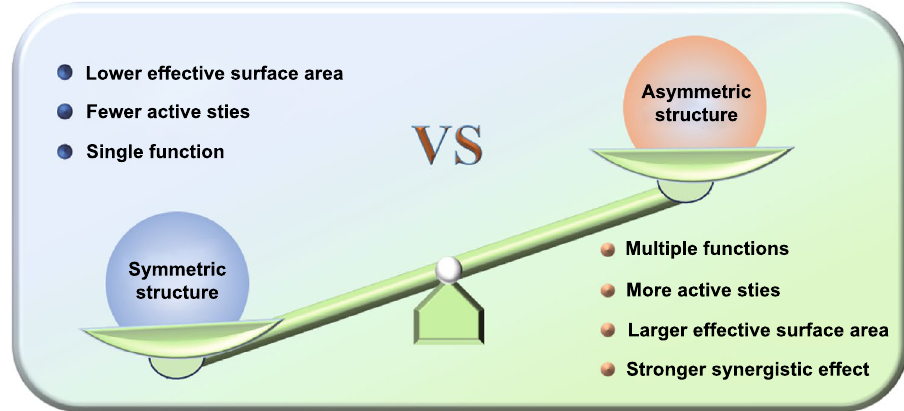
Fig. 2 Comparisons of advantages and disadvantages of symmetric and asymmetrical